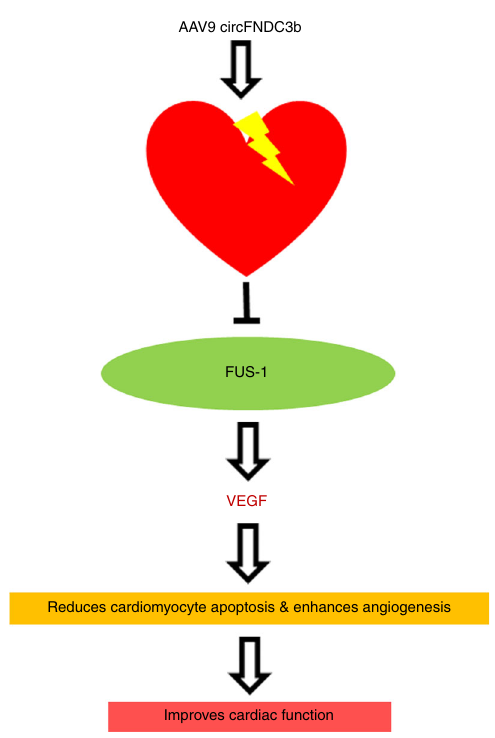
Fig. 8 Proposed mechanism of circFndc3b mediated cardiac repair: AAV9 circFndc3b therapy increases circFndc3b levels in the post-MI heart